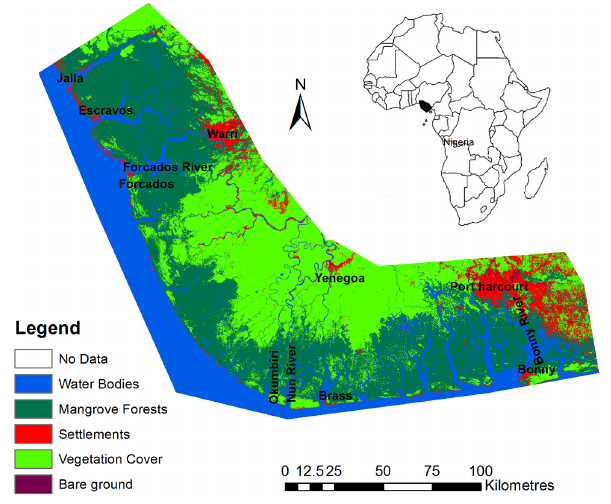
Figure 1. The Niger Delta land cover